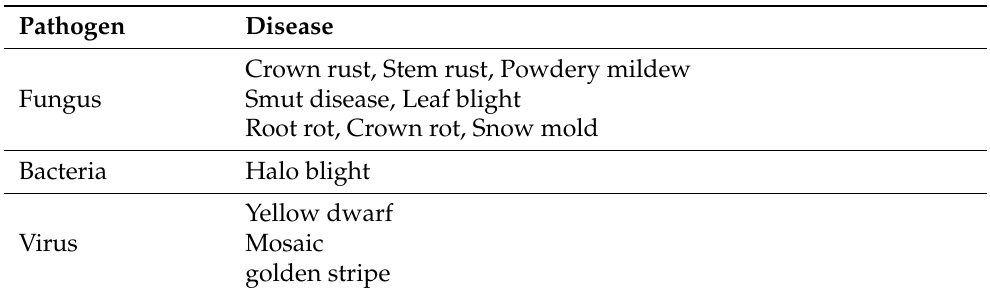
Table 7. Some Oats disease types and causing pathogens